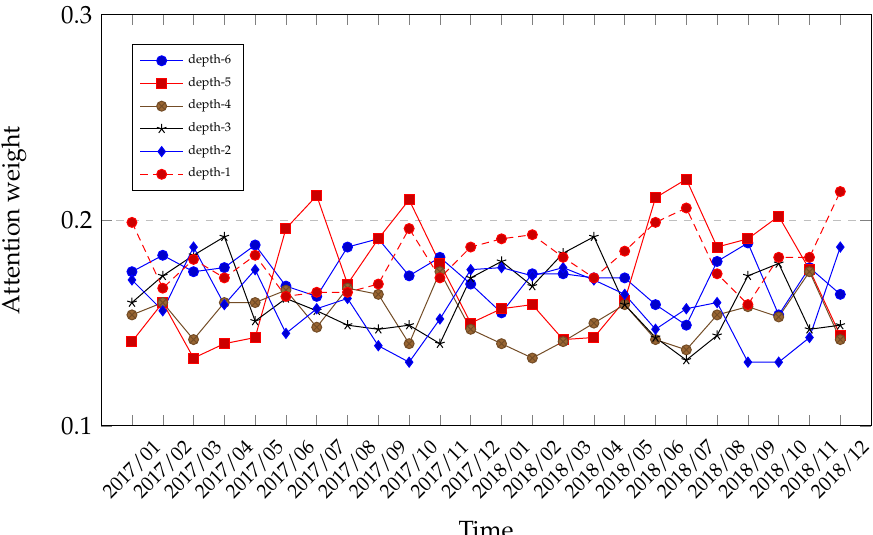
Figure 12. Attention weight on SP-CRN-2 (0,6,0) for SST prediction from the average of five runs. The attention weight of depth-1 to depth-6 was the value of prediction month on prior one to six periodic cycle. The scale is from 0.1 to